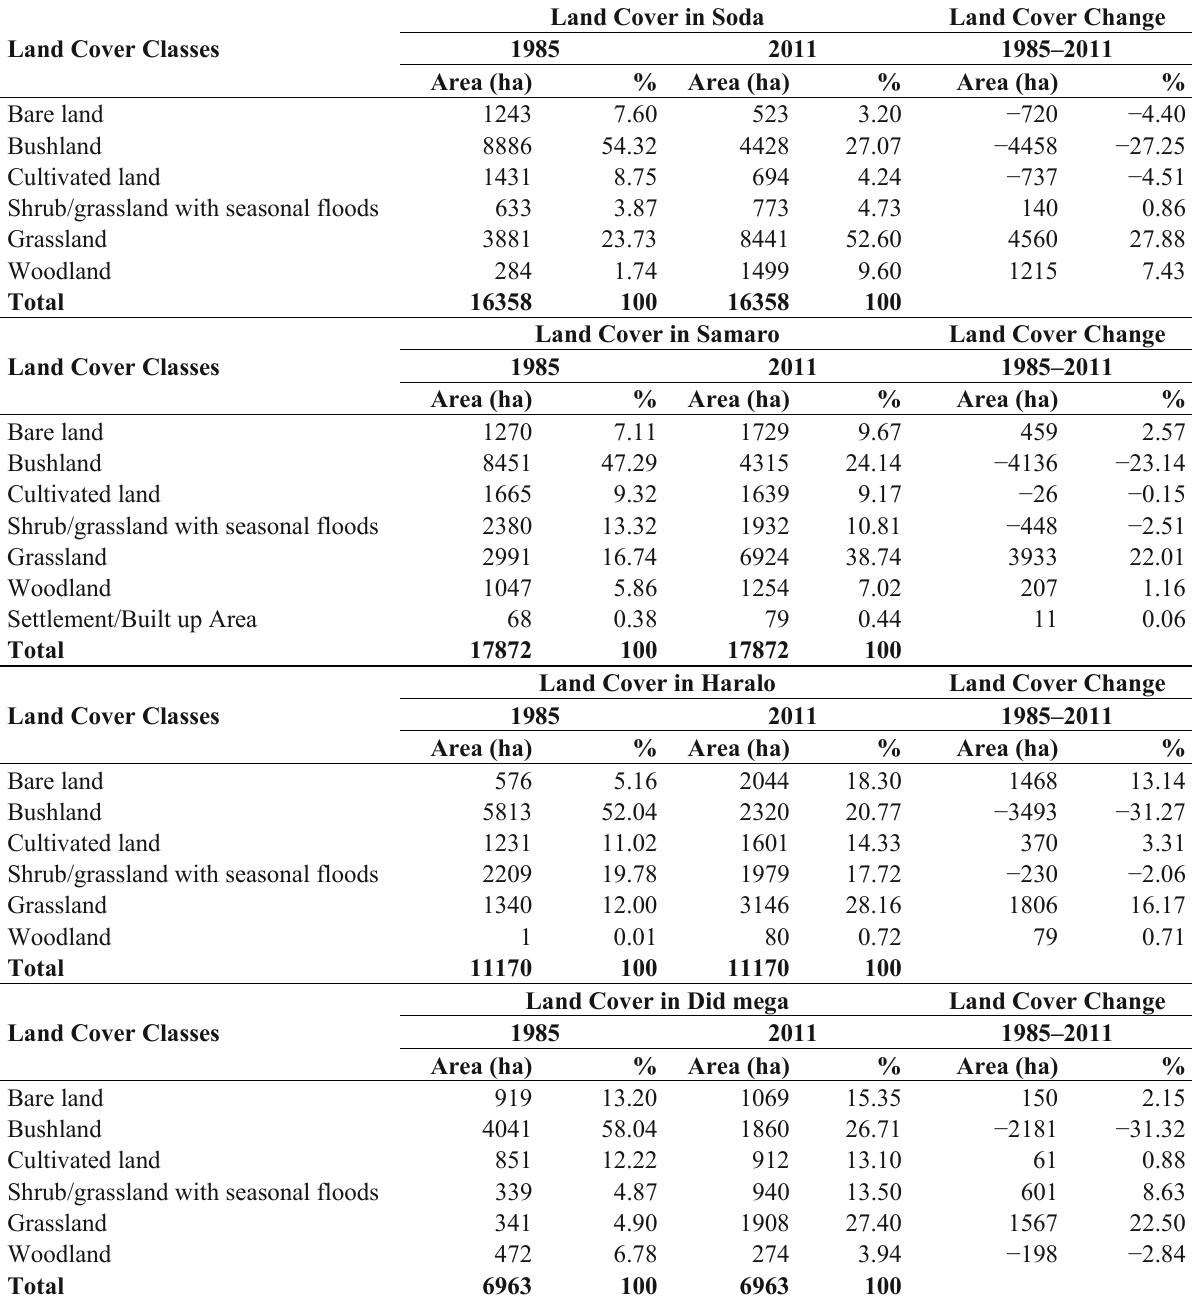
Table 3. Summary of the land cover classes and land cover changes in Soda, Samaro, Haralo, and Did mega